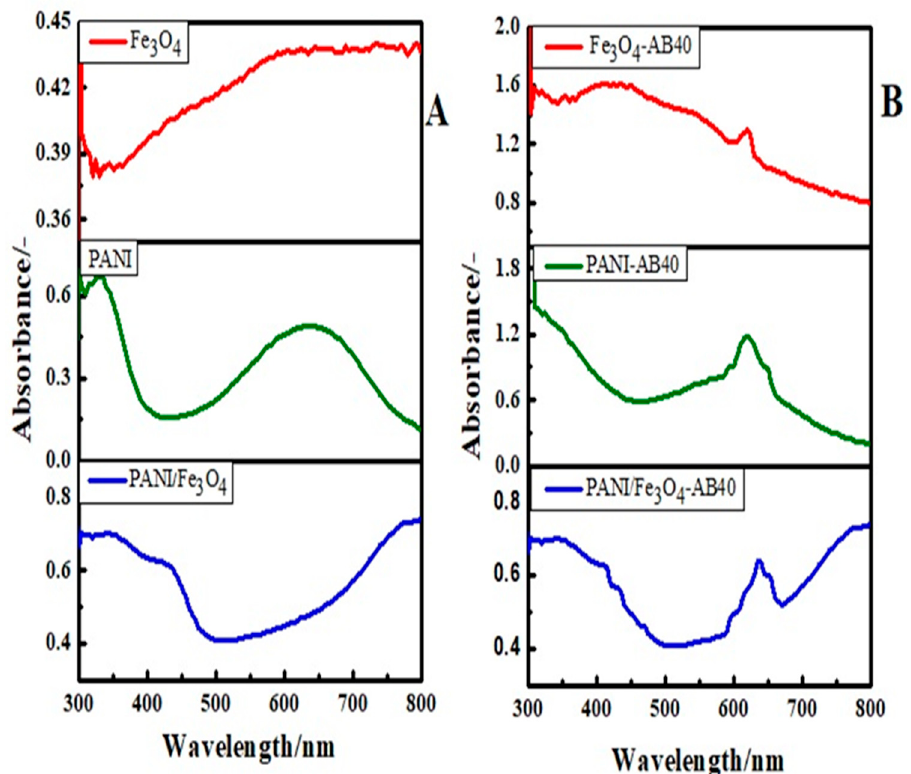
Figure 2. UV-visible spectrum of Fe 3 O 4 , PANI and PANI / Fe 3 O 4 composite ( A ) before and ( B ) after adsorption of AB40.